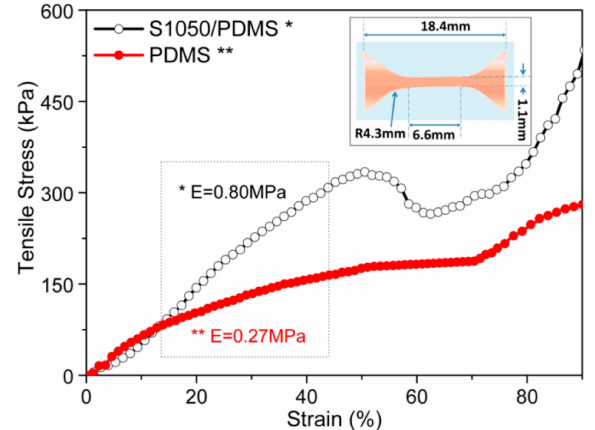
Figure 8. Static tensile properties of PDMS (close-symbol, red color) and S1050/PDMS composite film (open-symbol, black color). The inset is a schematic design of the film specimen according to the standard ASTM D412